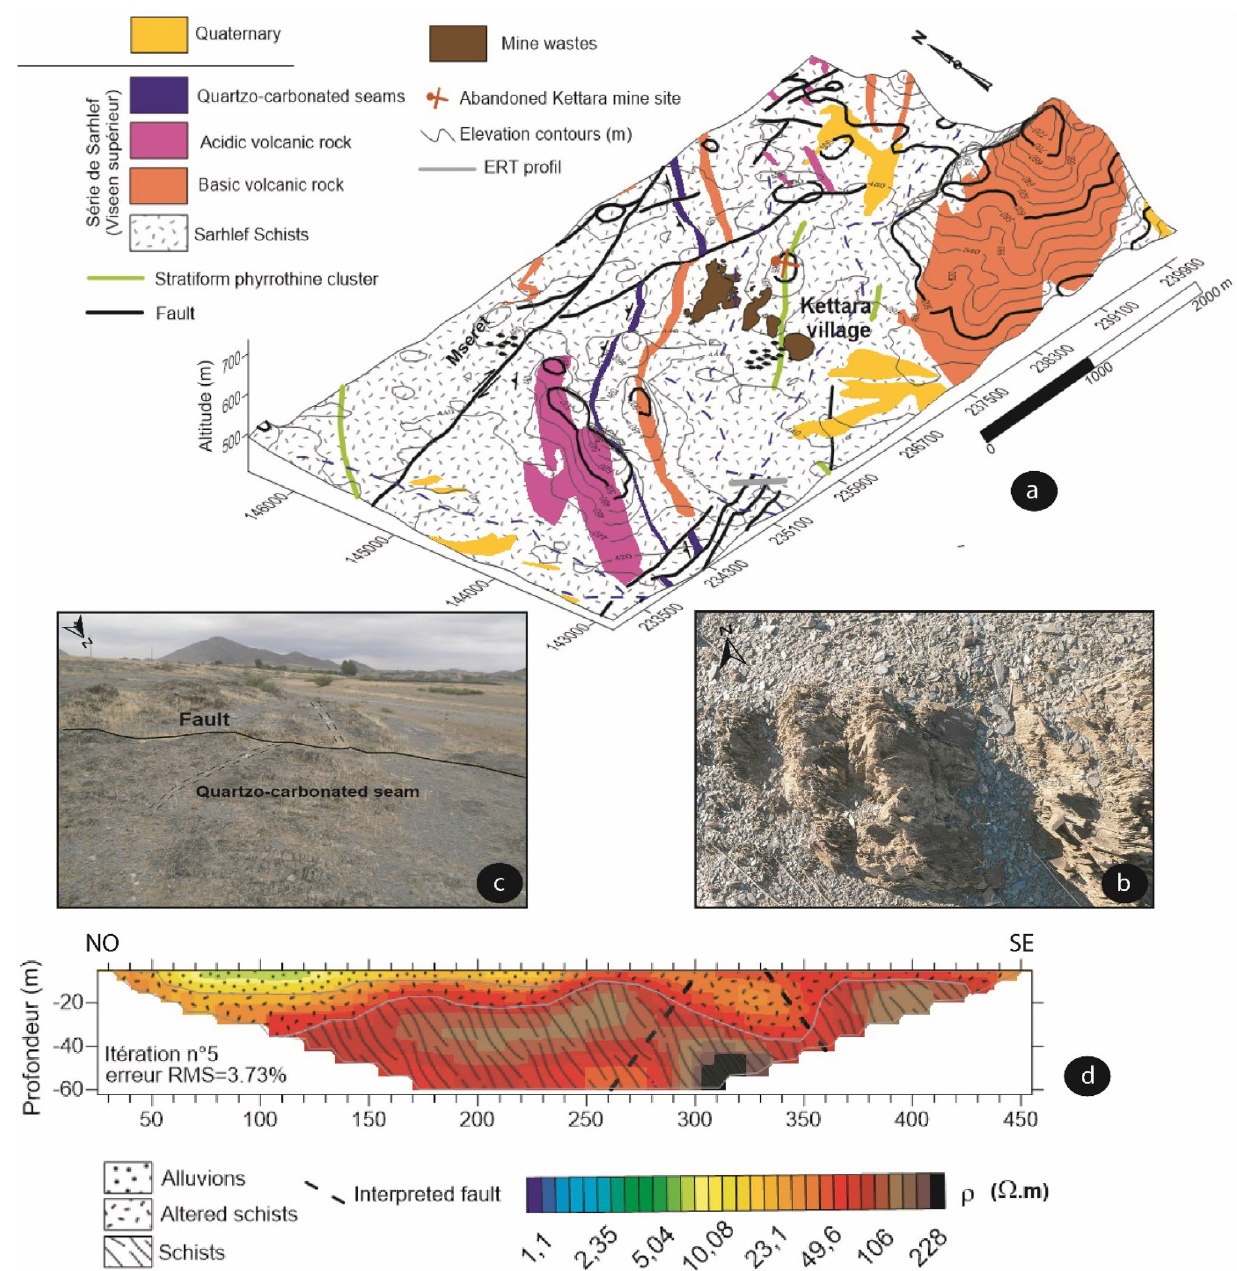
Fig.2 Geological map of Kettara mine site ( a ), tectonic structures: schistosity ( b ), quartzo-carbonated seam with fault ( c ) and electrical resis- tivity profile ( d